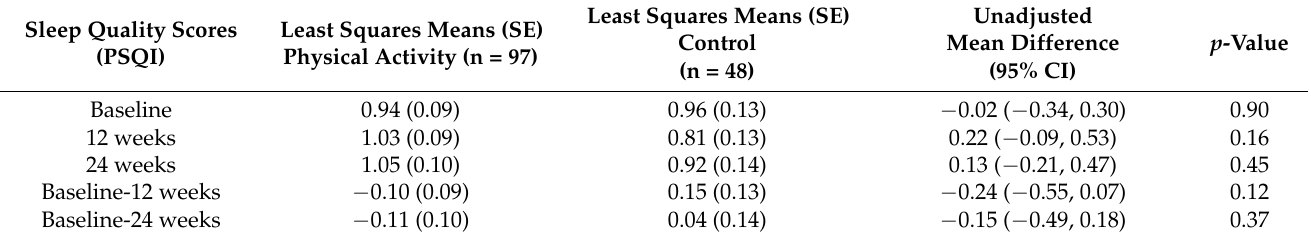
Table A2. Latency Component.